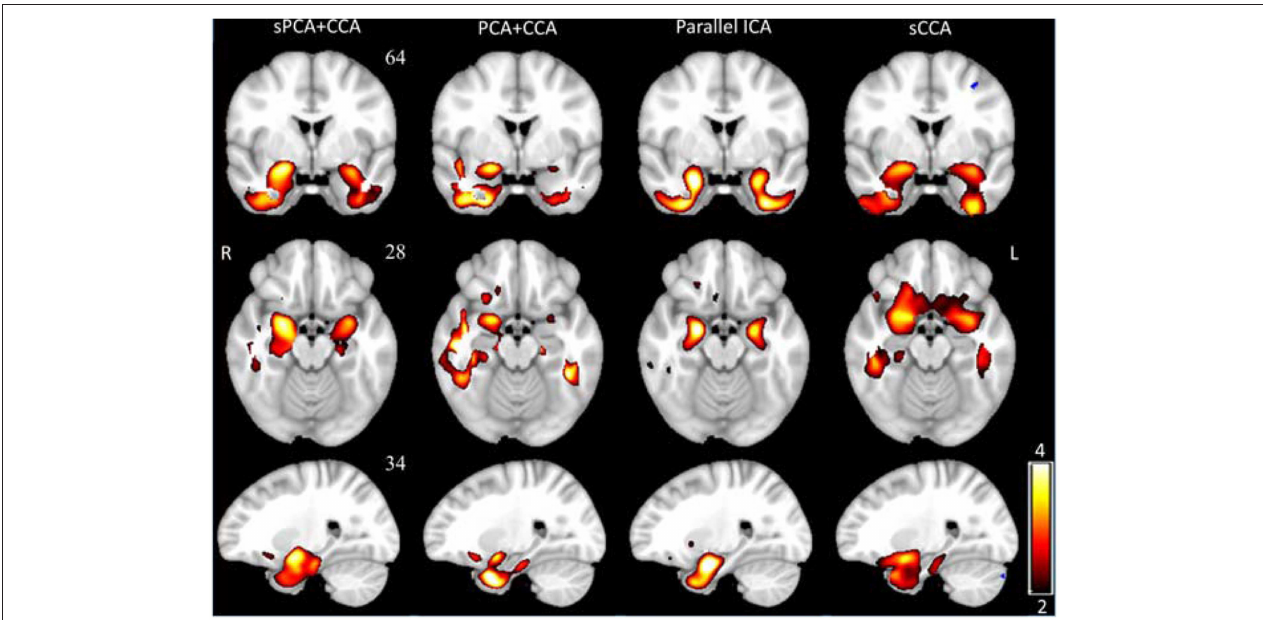
FIGURE 7 | The most significant disease-related VBM z-score maps from sPCA + CCA, PCA + CCA, parallel ICA and sCCA. Maps are displayed in radiological convention (right is left and vice versa). All spatial maps were thresholded at z > 2. Note that PCA + CCA does not give a bilateral disease-related pattern.